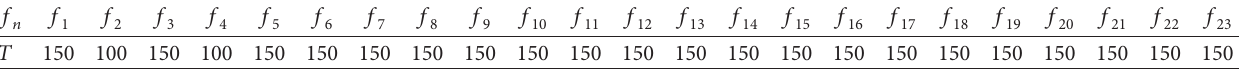
− f in SSMSEP, SSMSEP-1, SSMSEP-2, and 1 23